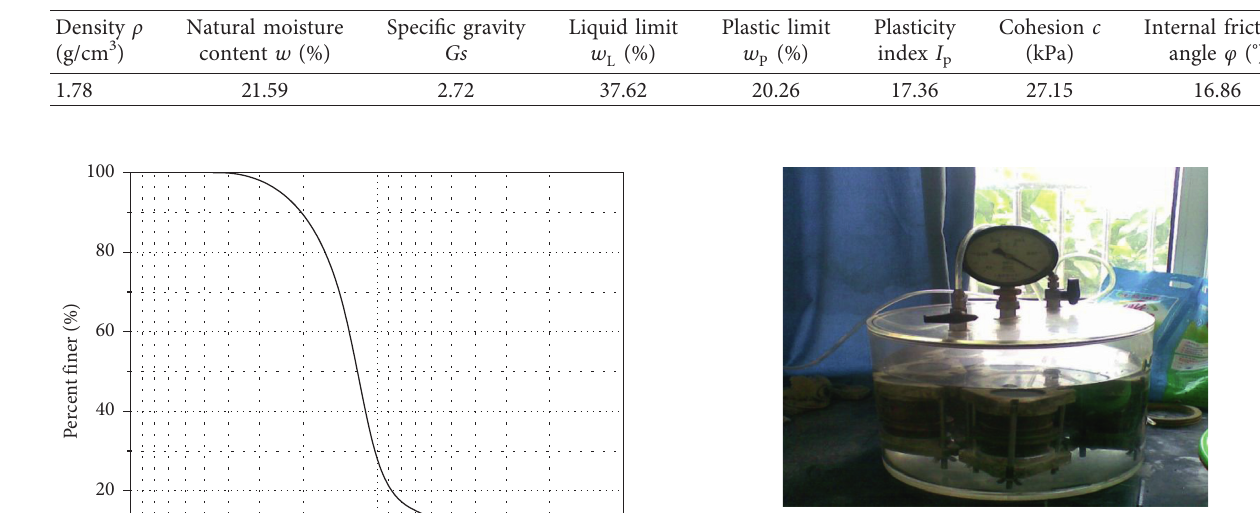
Table 1: Basic physical properties of clay.